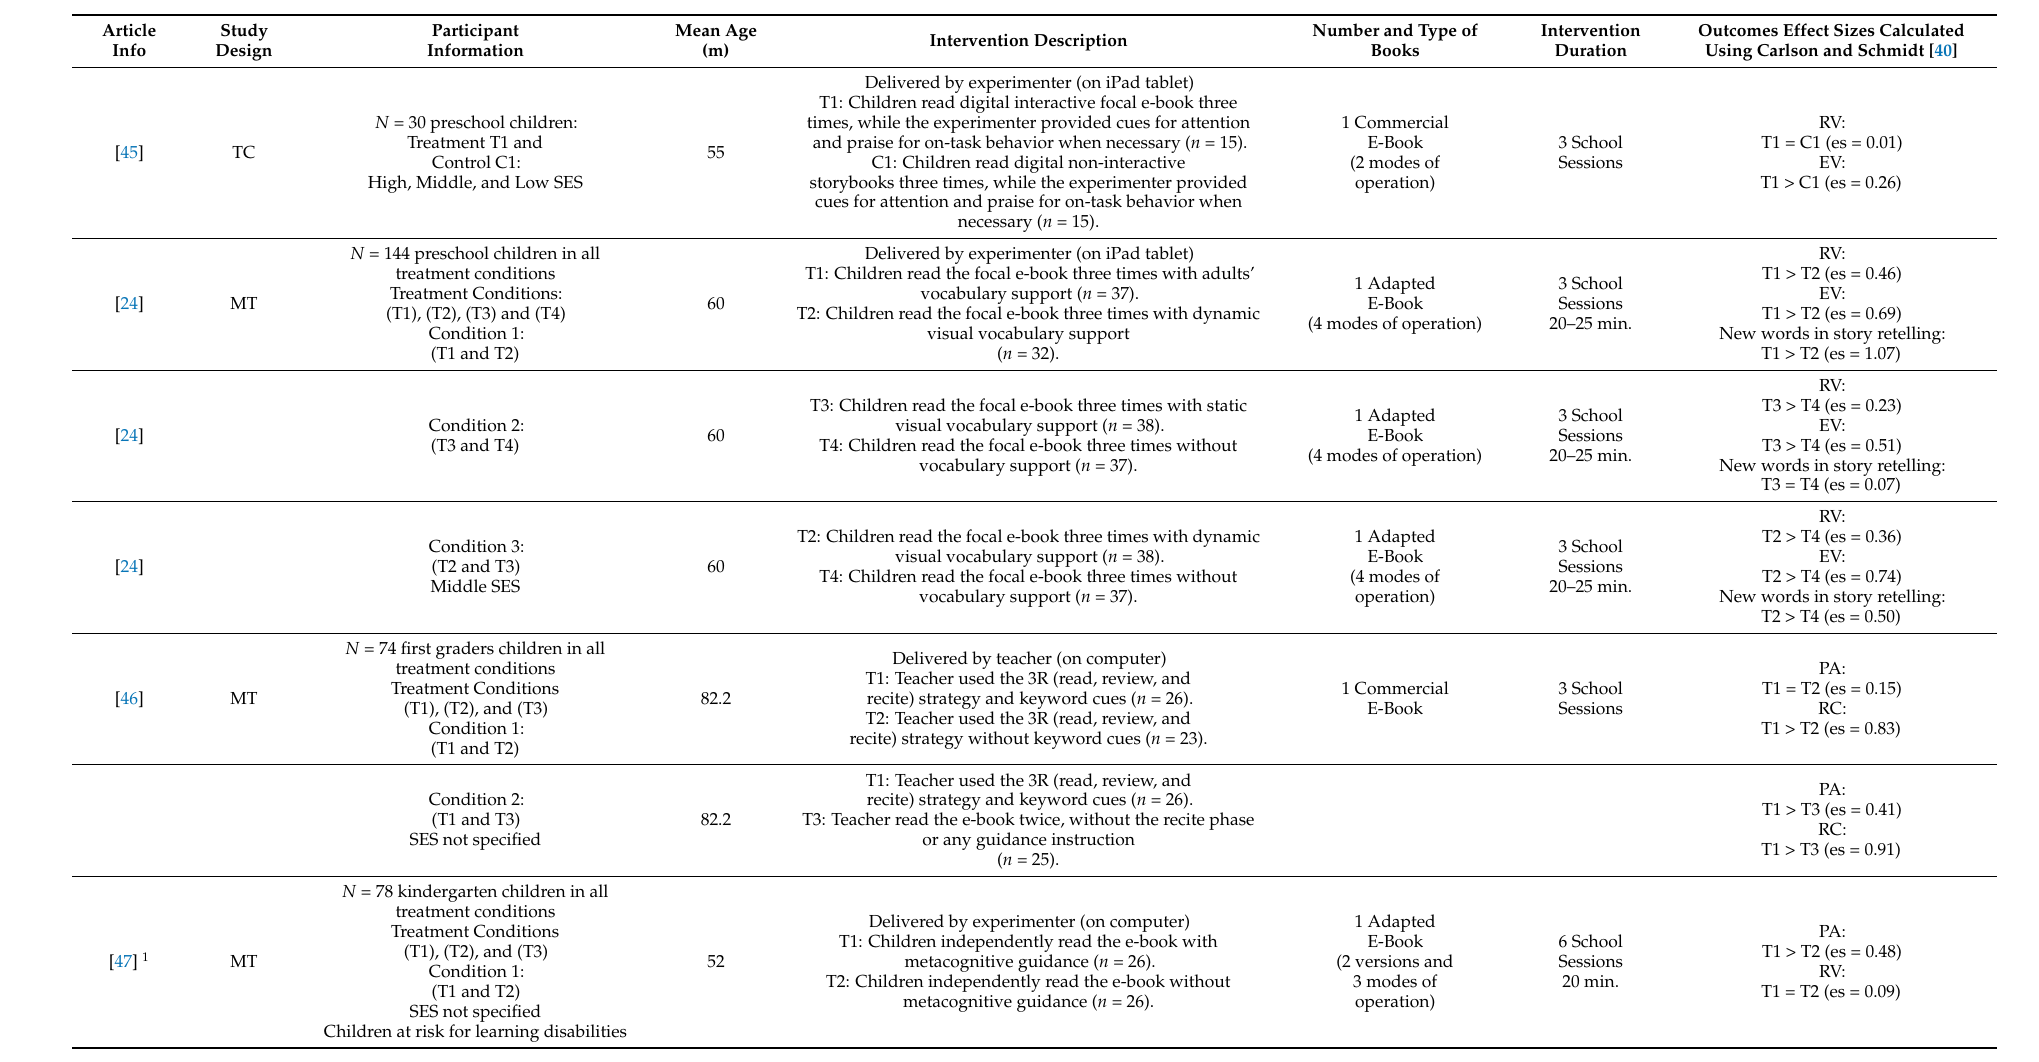
Table 2. Study information (enhanced e-books versus non-enhanced